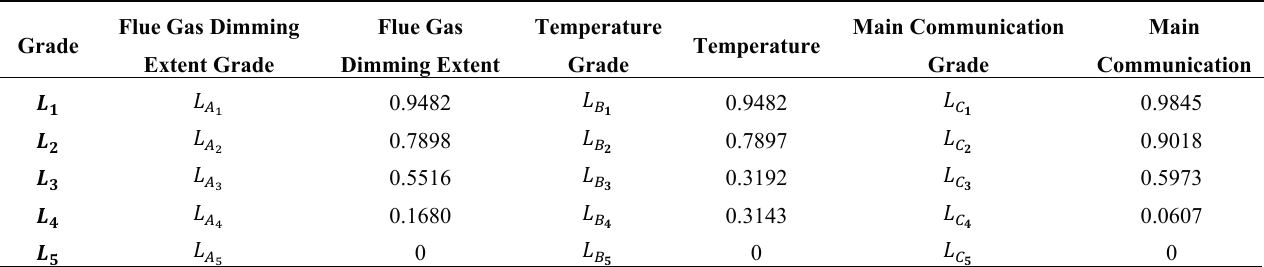
Table 2. Diagnosis grading system.